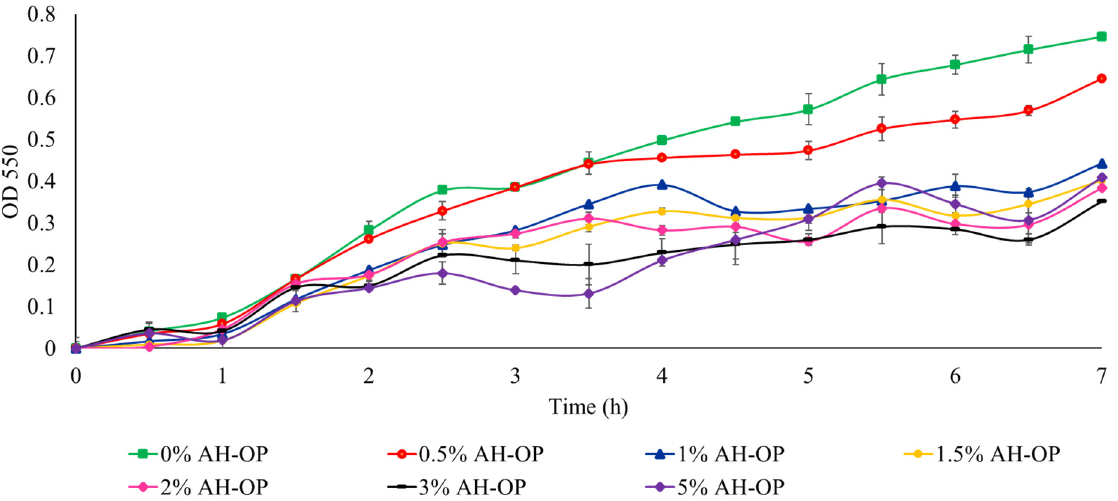
Figure 7. Growth rate of JM109 E. coli in the presence of acid hydrolyzed orange peel liquor (AH- OP).